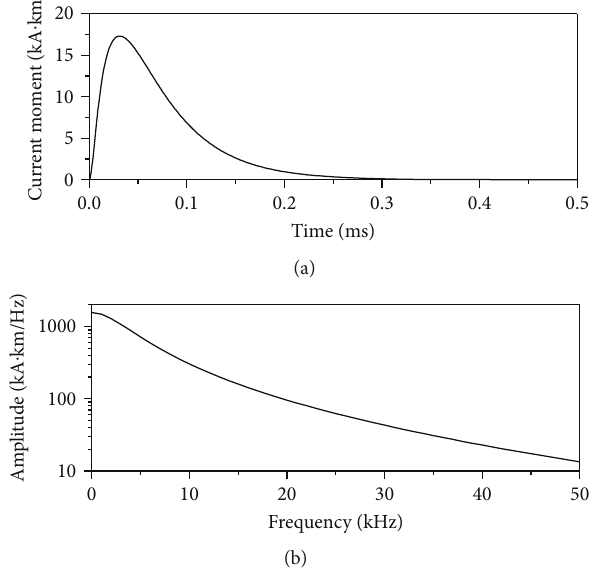
Solid: spherical earth Dashed: planar earth